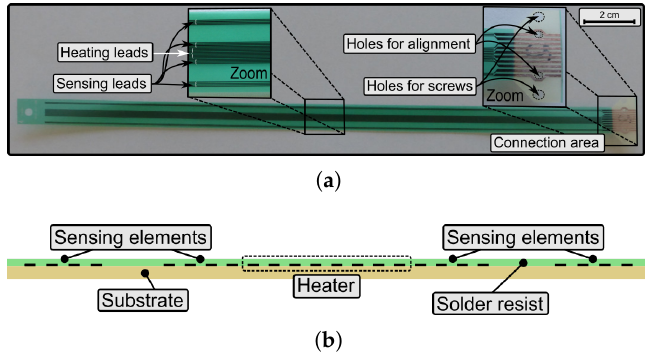
Figure 1. Sensor Design: ( a ) Photograph of the sensor layout with a length of 250mm. The left inset shows the copper leads (dark stripes) in detail: In the middle there is a heater and above and below there are four sensing leads; ( b ) FEM model cross-section. Heating and sensing elements (copper) are placed on top of a substrate (FR4 glass epoxy), passivated by a solder resist (polymide).